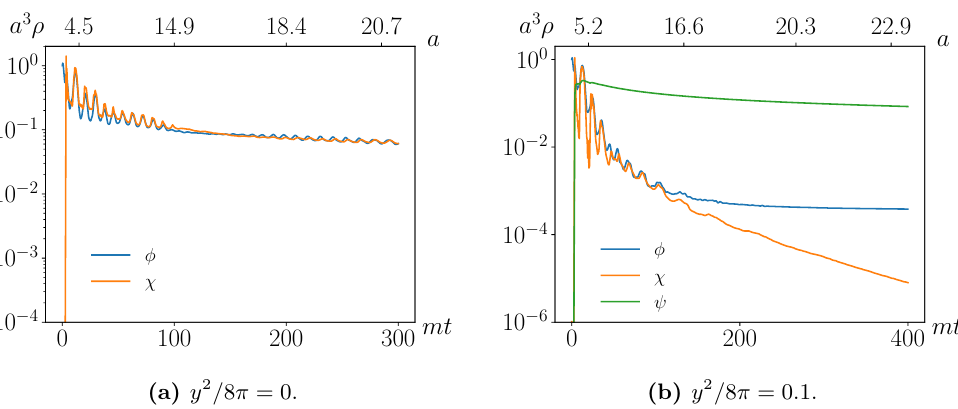
Figure 7. Time evolution of φ , χ , and fermion fluid energy density for b = 0 . 9 , m = 1 . 3 × 10 − 2 M pl , Φ = f = M , q = 200 and y 2 / 8 π = 0 or 0 pl 0